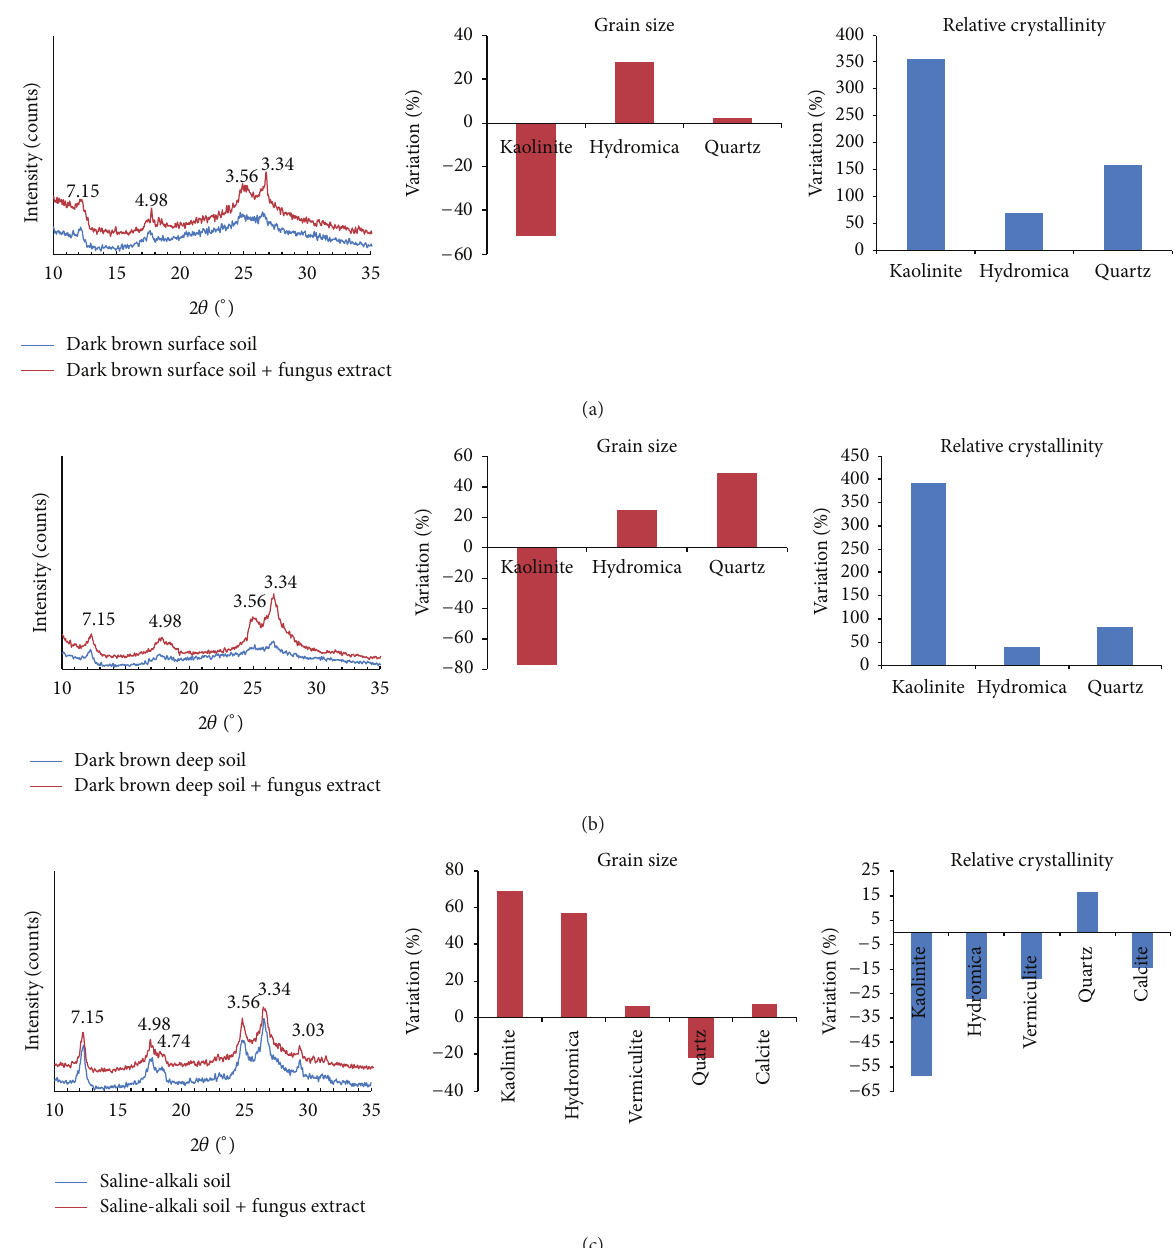
Figure 4: X-ray powder diffraction results with and without fungus extract addition. (a) Colloids from the surface layer of dark brown forest soil; (b) colloids from the deep layer of dark brown forest soil; (c) colloids from saline-alkali soil.